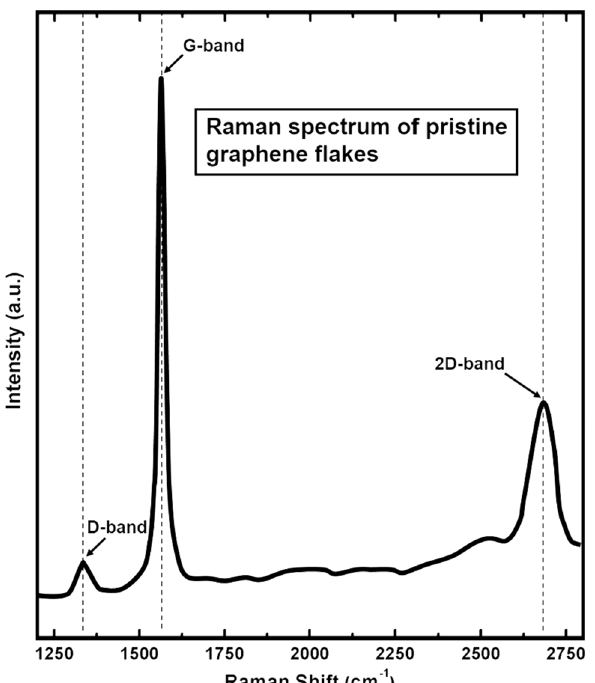
Fig. 1 Typical Raman spectra obtained from pristine graphene nano- flakes prior to